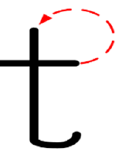
Figure 14. Link between the two portions of “t”.